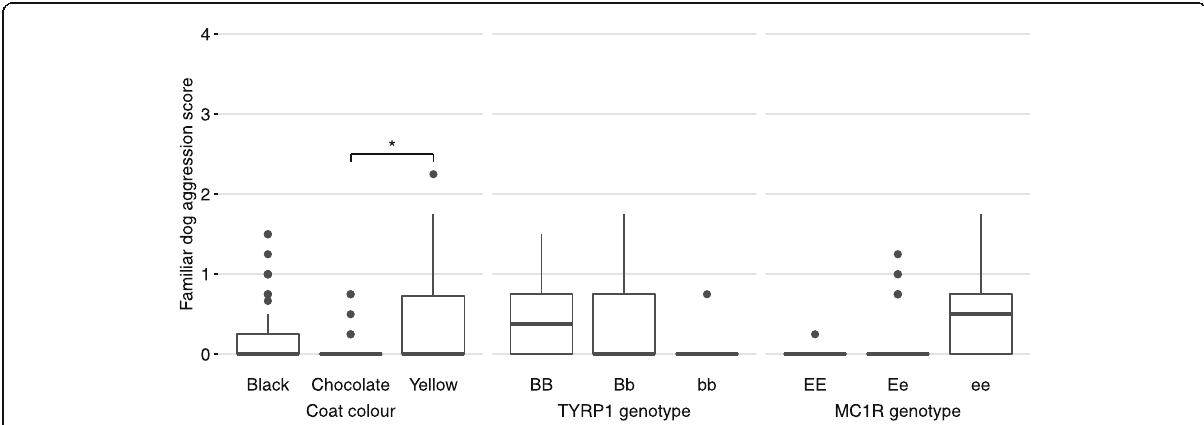
Fig. 1 boxplots of Familiar dog aggression score. Significant differences between the groups calculated by Mann Whitney U test with Bonferroni